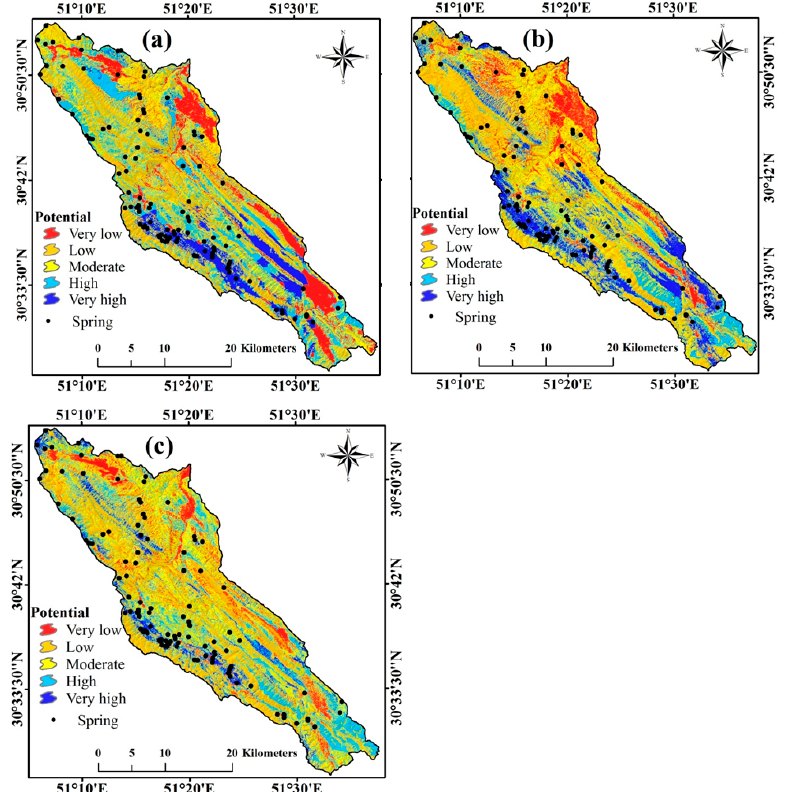
Figure 5. Karst groundwater potential maps generated by ( a ) entropy ‐ SVM ‐ RBF, ( b ) entropy ‐ SVM ‐ SIG, and ( c ) entropy ‐ SVM ‐ LN. The results indicate that 11.6%, 20%, and 10% of the study area was classified as hav ‐ ing very high potential by entropy ‐ SVM ‐ RBF, entropy ‐ SVM ‐ SIG, and entropy ‐ SVM ‐ LN (Figure 6). On the contrary, 18.5%, 21%, and 19% of the watershed was classified as having very low groundwater potential by the models (entropy ‐ SVM ‐ RBF, entropy ‐ SVM ‐ SIG, and entropy ‐ SVM ‐ LN). Figure 6. Percentage of karst groundwater potential classes in the study area. 3.5. Validation Analysis The validation analysis showed that the entropy ‐ SVM ‐ RBF model (AUC = 0.911) was most accurate (Figure 7 and Table 4). The standard error values of entropy ‐ SVM ‐ RBF were the smallest as well. The entropy ‐ SVM ‐ RBF produced the following metrics: SE = 0.0185, sensitivity = 92.17, specificity = 75.65, PPV = 79.1, NPV = 90.6, and accuracy = 92.1. This was the highest accuracy score among the models. Generally speaking, all three ensemble V er y l o w L o w M o d er a t e H i g h V er y h i g h Models